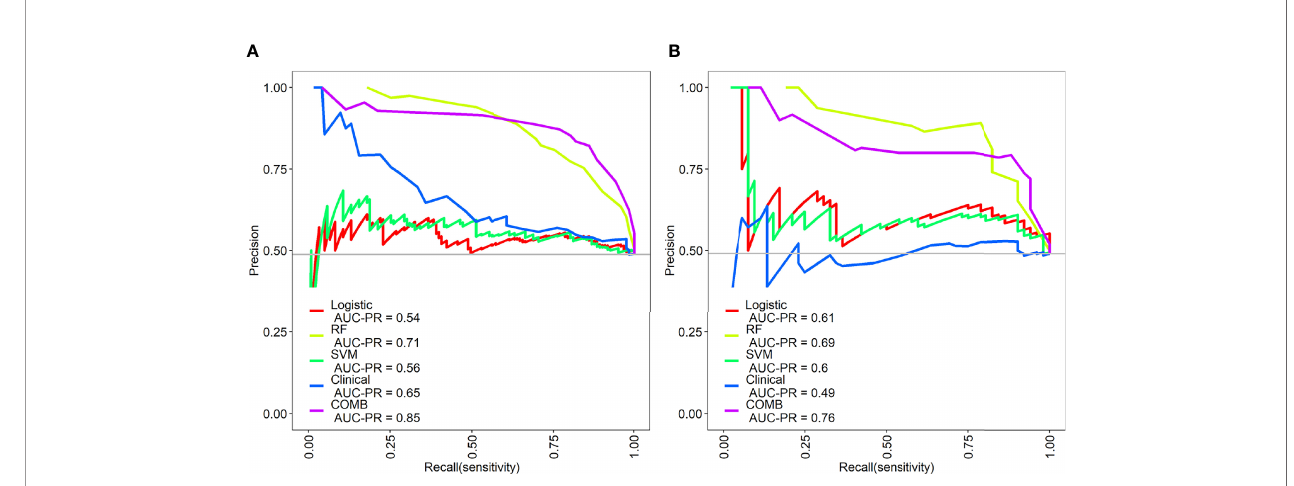
FIGURE 6 | Precision-recall (PR) curves of the different models in the training (A) and validation sets (B) . PR represents the relationship between precision and recall.The larger the area under the PR curve, the better the model